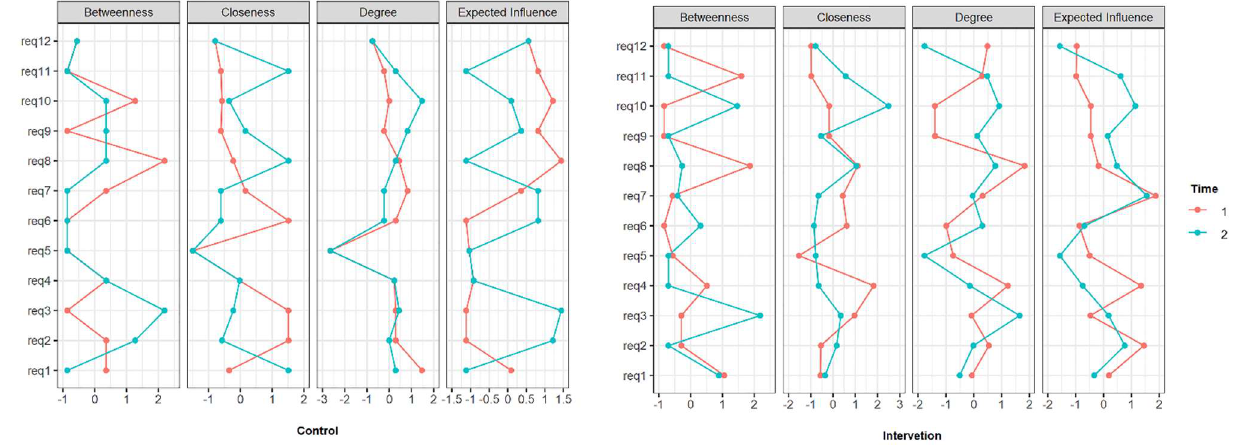
Figure 8. Networks analyses property.